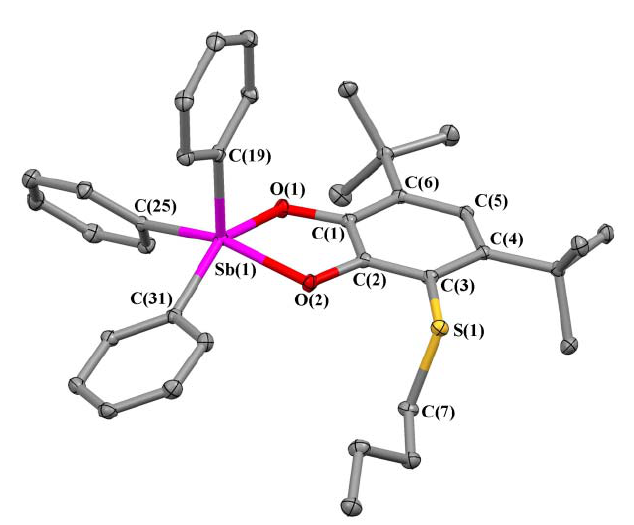
Figure 1. The X-ray structure of (3-BuS-4,6-Cat)SbPh 3 ( 1 ). Hydrogen atoms are omitted, ellipsoids of 30%